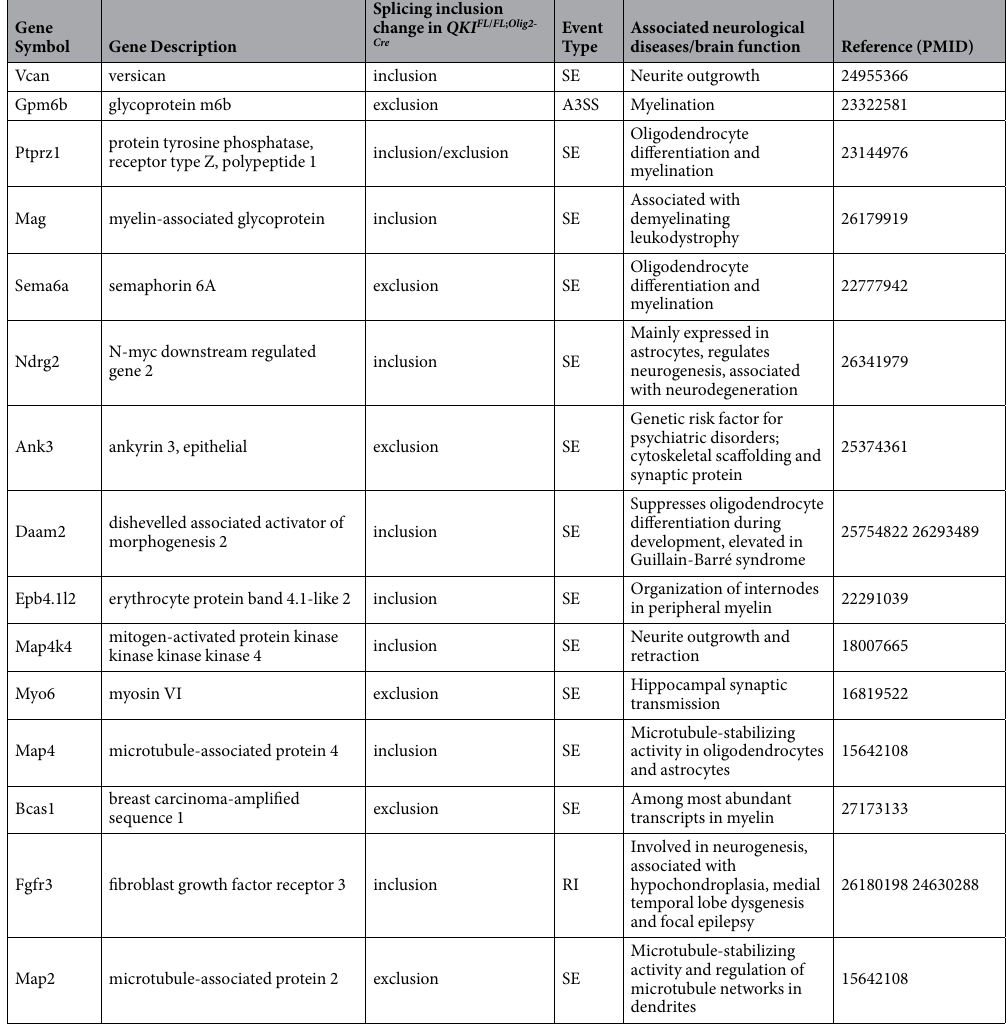
Table 1. A large number of novel AS events observed in QKI FL / FL ; Olig2 - Cre mice are located in genes associated with neurological diseases and/or involved in important brain function, with the top 15 represented in this table. Abbreviations: SE: skipped exon, A5SS: alternative 5 ′ splice site, A3SS: alternative 3 ′ splice site, RI: retained